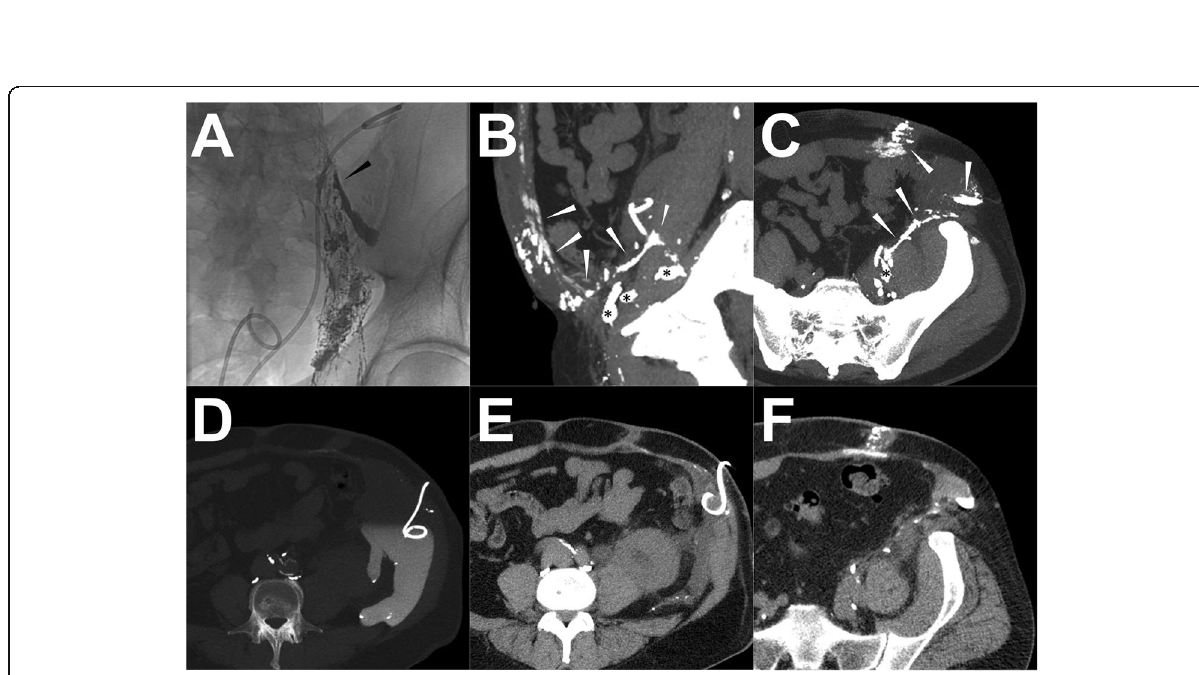
Fig. 5 A patient underwent a DLS procedure after post-LAG CT. Note: Conventional iodized oil-based LAG showed the extravasation (black arrowhead) from the left iliac LVs ( a ). From the sagittal ( b ) and axial MIP ( c ) images of post-LAG CT is demonstrated an obvious LF (white arrowhead) from the iliac LVs into the peripheral lymphocele around the transplanted kidney. The afferent LNs could be identified (*). A pigtail drainage catheter was inserted into the lymphocele before the local sclerotherapy ( d ). After running out of all the lymphatic fluid, 15 ml of 95% Ethanol as the sclerosant was injected to flush the lymphocele and then this was drawn out twice. Eight (8) days after DLS, the CT scan revealed very limited residual lymphatic fluid ( e, f ). Abbreviations: DLS – direct leakage sclerotherapy; post-LAG CT – post-lymphangiographic computed tomography; LAG – lymphangiography; LVs – lymphatic vessels; MIP – maximum intensity projection; LF – lymphatic fistula; LNs – lymph